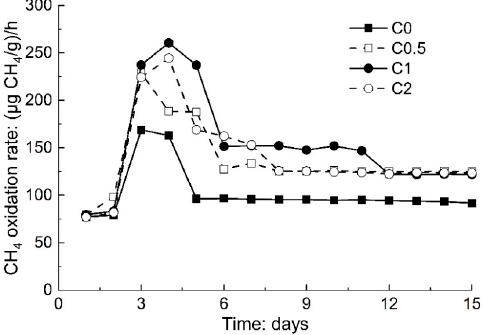
Figure 7. Methane oxidation rate of cover soil with different gas compositions versus time.